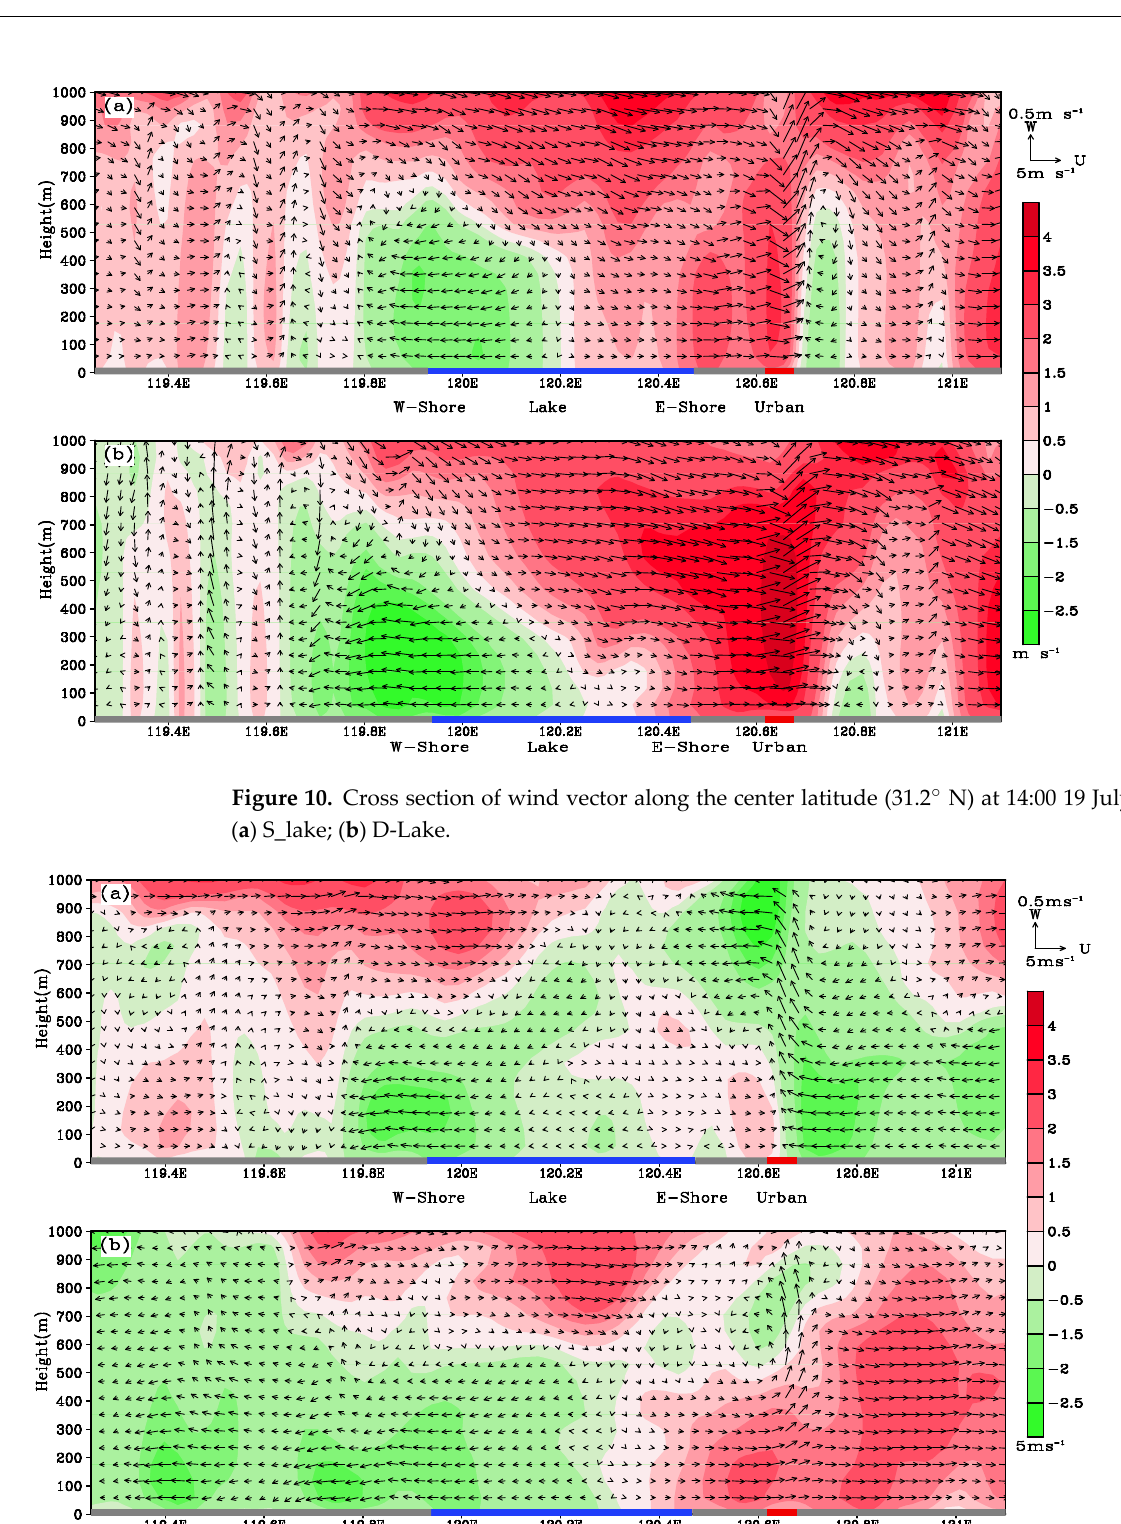
◦ N) at 19:00 19 July 2012 by